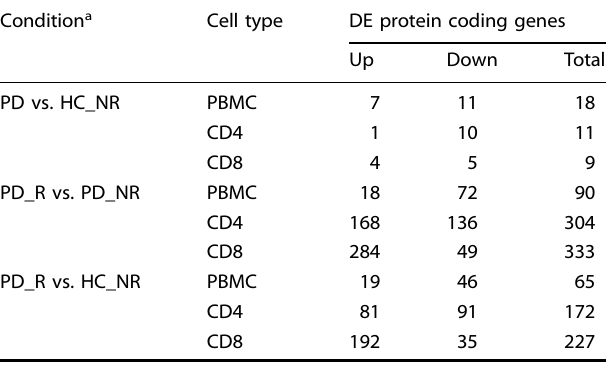
Fig. 1 Classi fi cation of PD and age-matched HC based on the α -syn T cell response. a Violin plot shows the magnitude of T cell response (sum of IFN- γ , IL-5, and IL-10) in HC non-responders (HC_NR) ( n = 20) PD responders (PD_R) ( n = 15), and PD non-responders (PD_NR) ( n = 21). The dotted line denotes the cut-off value of 250 SFC. Two-tailed Mann – Whitney, **** p < 0.0001. b The gating strategy was adopted to identify and sort PBMC, CD4, and CD8 memory T cells from PD and HC subjects. Table 1. Number of differentially expressed genes in different